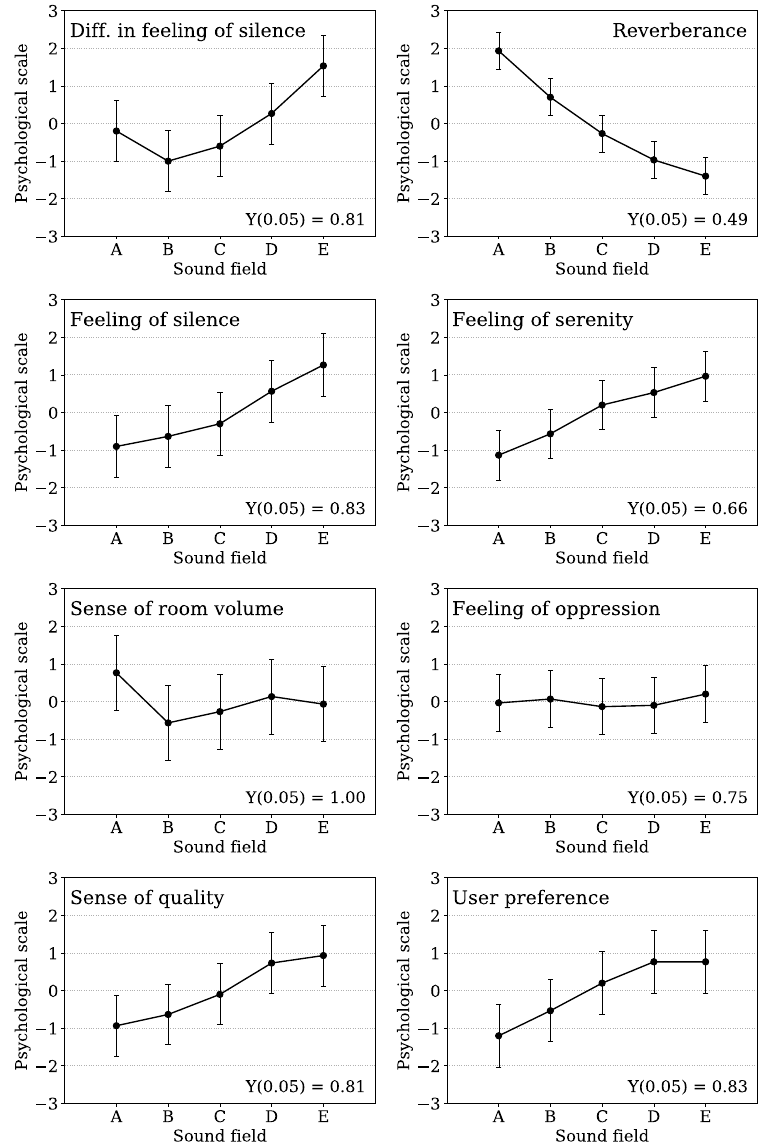
Figure 5. Results of psychological experiments using the full-scale room model. The eight figures show the psychological values of the five absorption patterns (A–E) for each subjective item. The error bars represent the 5% significant